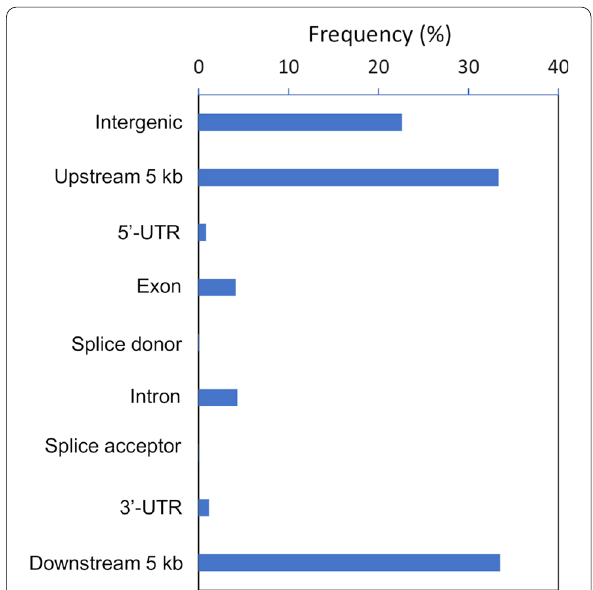
Fig. 2 Annotation of SNVs classified based on their location in the IRGSP-1.0